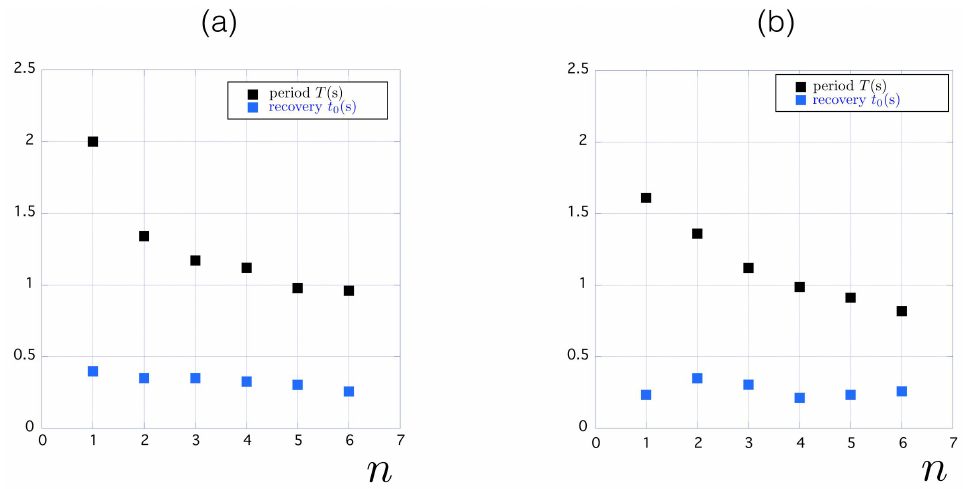
Figure 11. Evolution of the period T and of the recovery time t 0 as functions of the cycle number n during the two standing starts presented in Figure 9: ( a ) Athlete A1, ( b ) Athlete